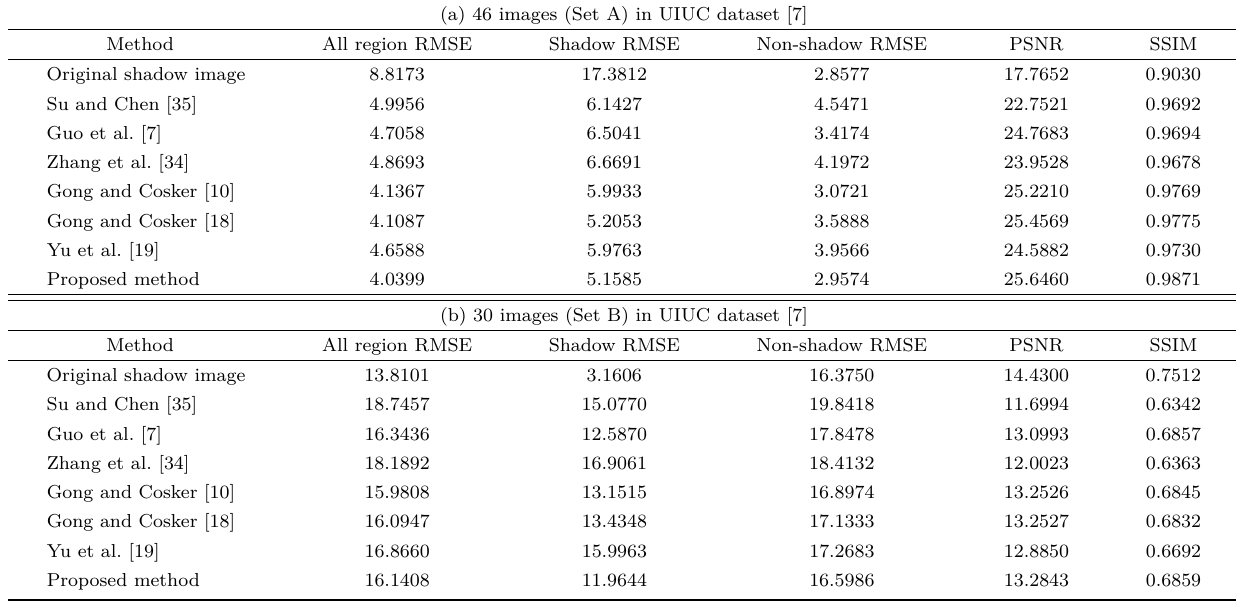
Table 1 Quantitative results on the images from the UIUC dataset [7]. (a) Images for which the ground truth is created by removing the object causing shadow. (b) Images for which the ground truth is created by removing the light source responsible for the appearance of the shadow. Values are averages computed over the set of images